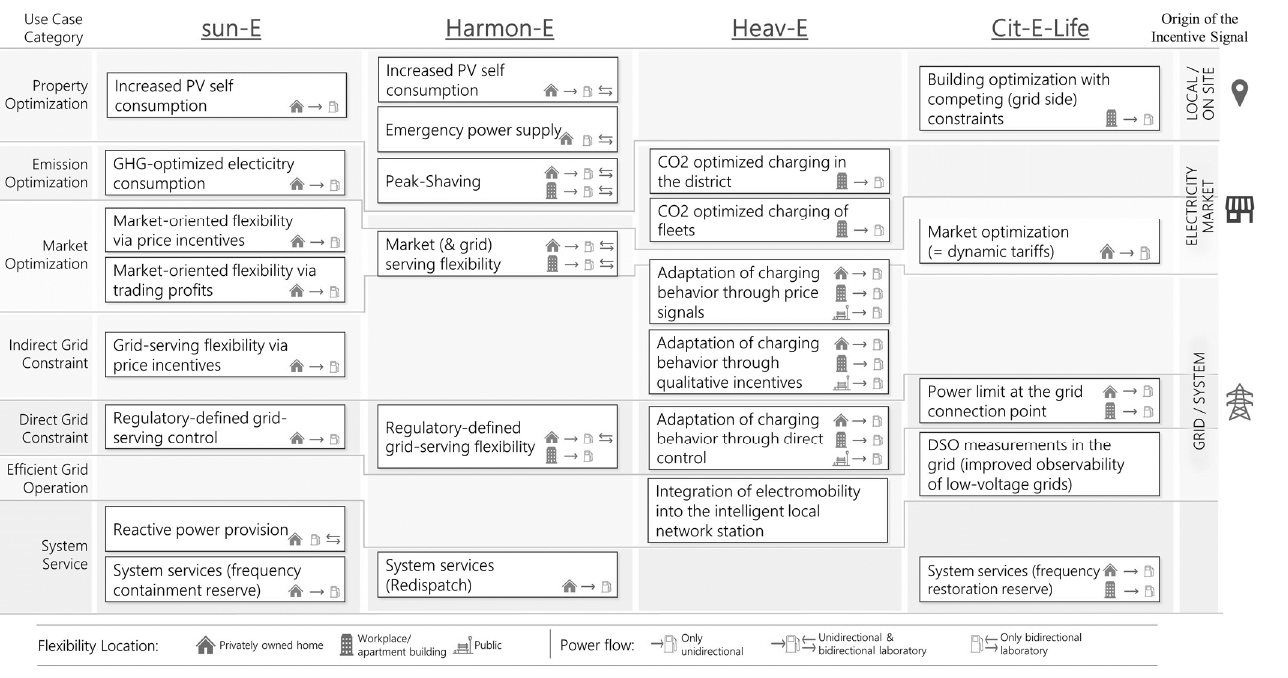
Figure 2. Overview of BUCs in unIT-e 2 project grouped per cluster and incentive signal.